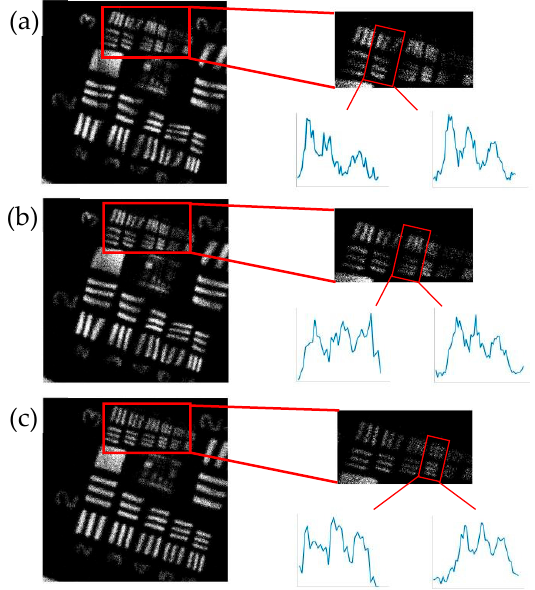
Figure 10. Image obtained with ( a ) G3S, ( b ) G5S, and ( c ) MCoG algorithm, respectively. The insets in the figure show that histograms through the vertical and horizontal lines of minimum element can be distinguished. The resulting image obtained with MCoG centroiding takes into five largest strips above a threshold Th fixed at 3% of total per-axis charge.